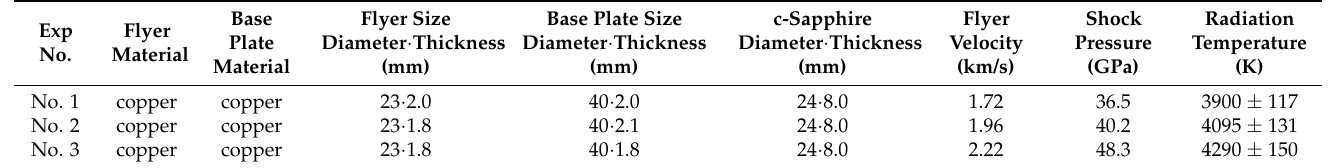
Table 2. Fitting results of experimental shock pressure and temperature of sapphire.